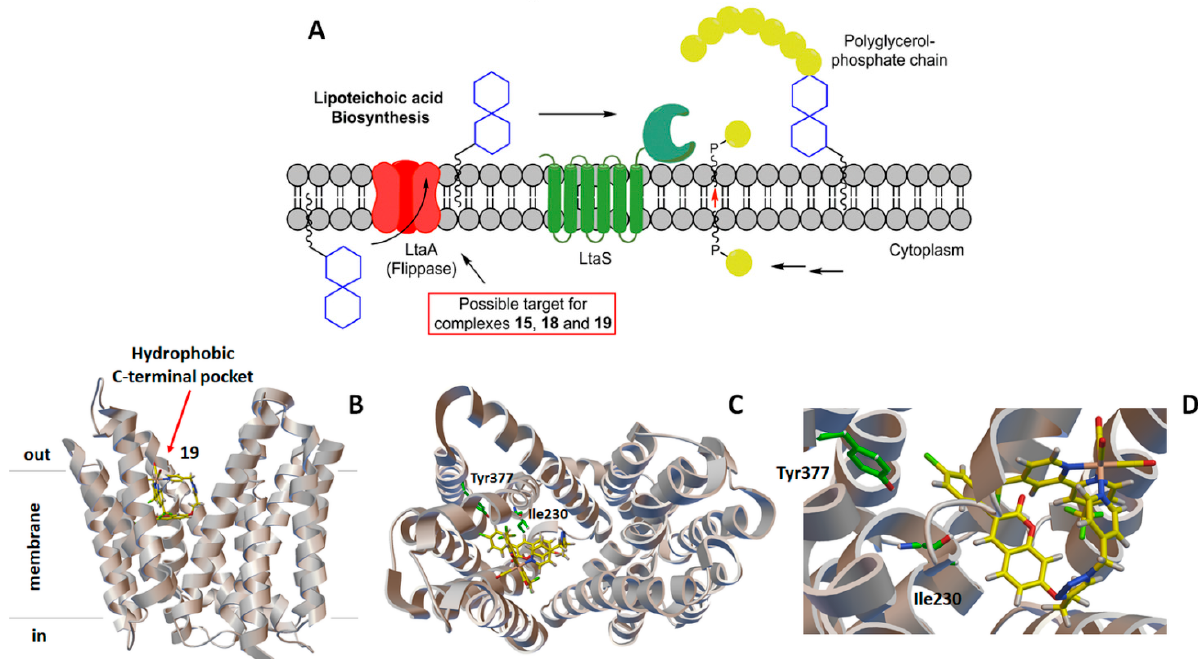
Figure 5. ( A ) Schematic diagram of the lipoteichoic acid synthetic machinery in MRSA with the possible target of the active antimicrobial rhenium complexes. For more details about scheme ( A ), see [75] . Computer-generated lowest energy pose of the selected complex 19 in the hydrophobic C-terminal pocket of lipoteichoic acid flippase (LtaA): ( B ) side view; ( C ) top view; ( D ) detail of the binding region. In ( C , D ), the two amino acid residues most likely involved in the H-bonding interactions with 19 are shown in green.